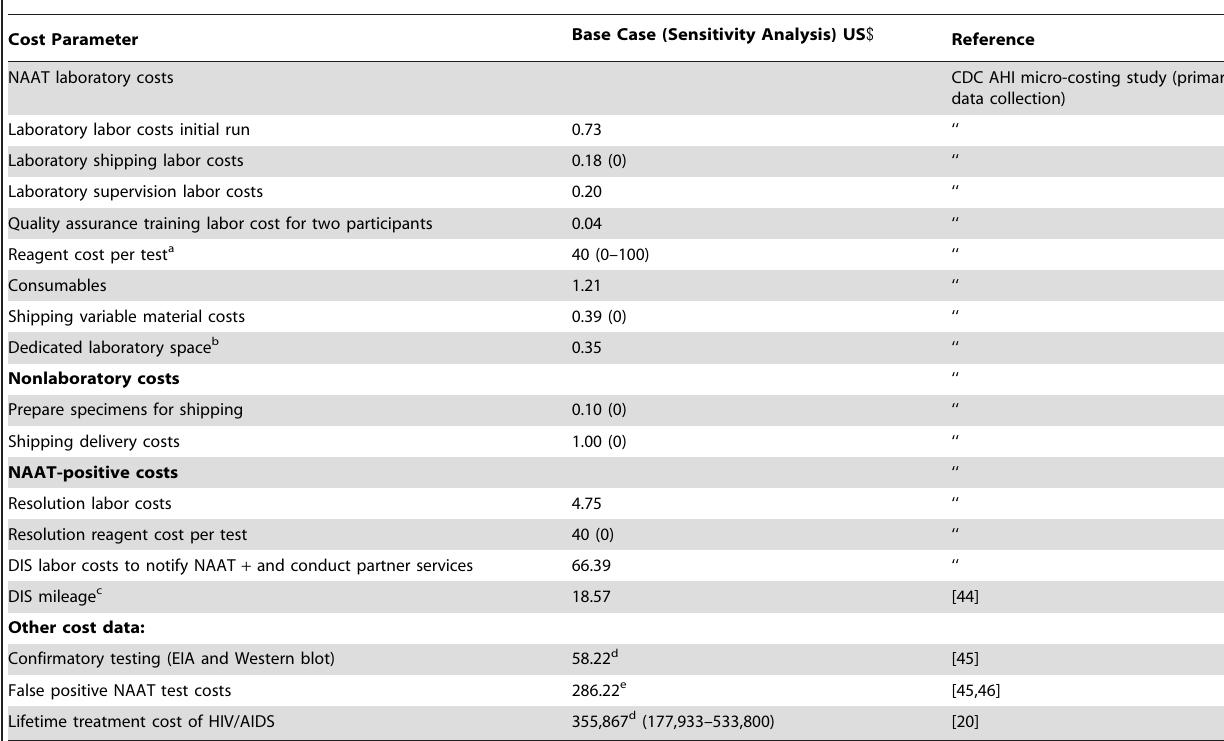
Table 1. Cost parameters: Expressed as cost per specimen tested unless otherwise